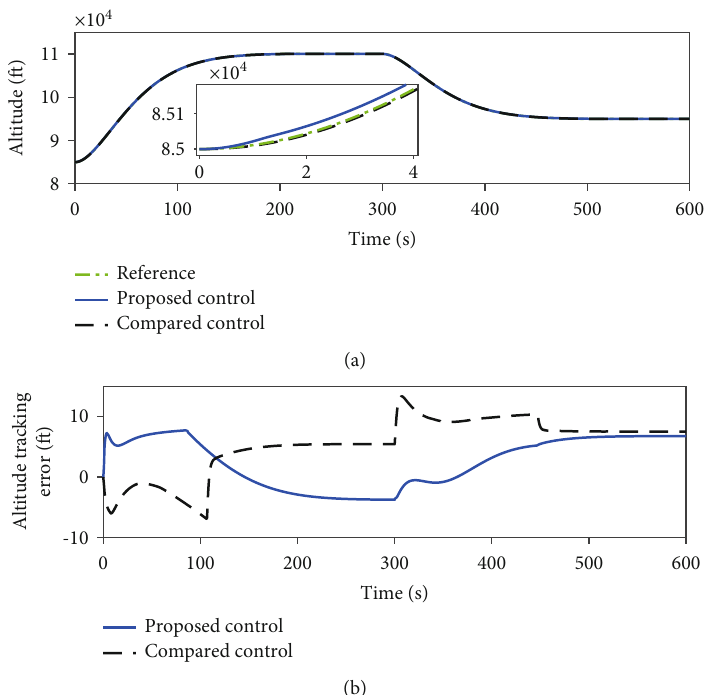
Figure 2: Altitude tracking results in the comparison simulation: (a) altitude tracking; (b) altitude tracking